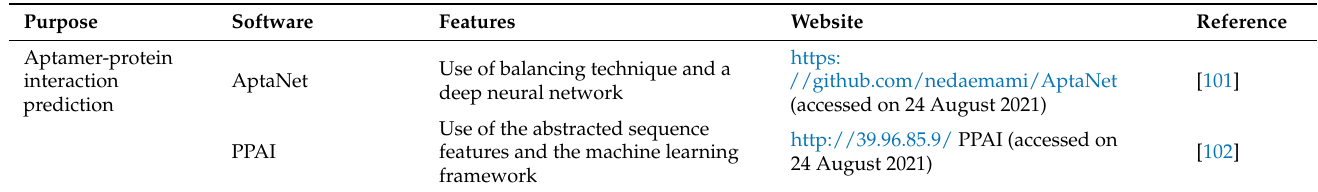
Table 4. Software used for the characterization of